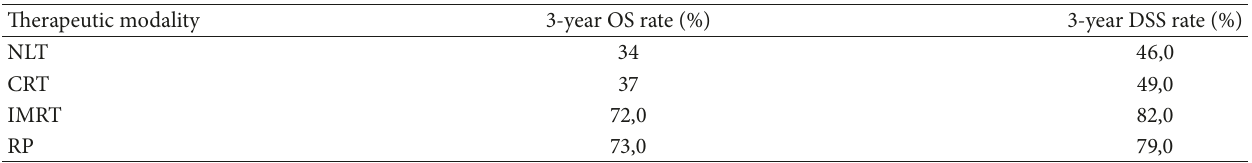
Table 7: Overall survival and disease-specific survival by therapeutic modality, adapted from Satkunasivam et al. (2015) [15]. Therapeutic